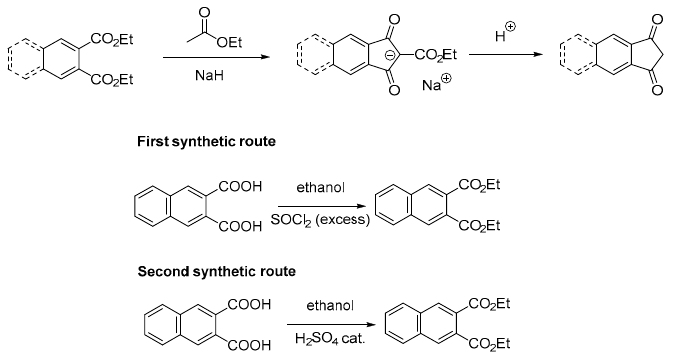
Figure 4. Synthetic route to 1,3-indanedione derivatives by the Claisen condensation and the two possible esterification procedures for naphthalene-2,3-dicarboxylic acid.